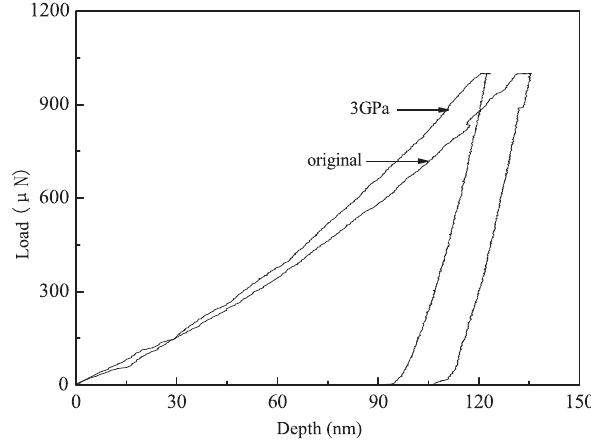
Fig. 5: Load-displacement curves for nano-indentation tests of the CuZn